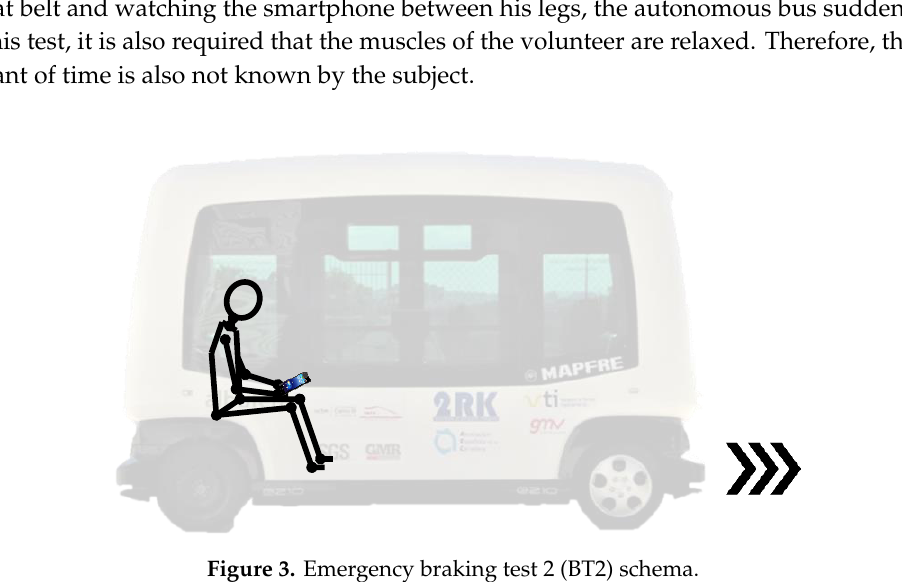
Figure 3. Emergency braking test 2 (BT2) schema.